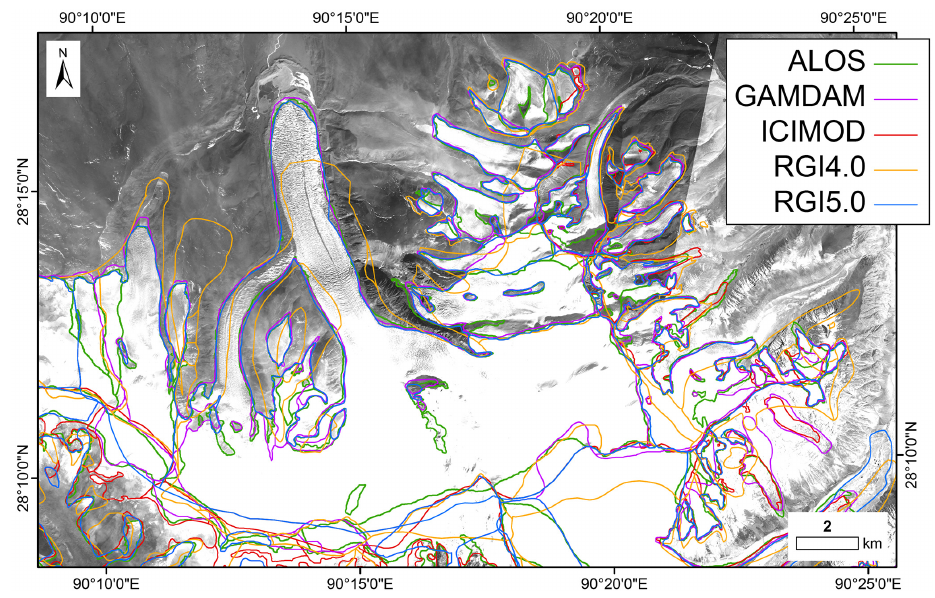
Figure 18. Glacier outlines containing significant distortion in the RGI4.0. These have been improved for the RGI5.0 and are now consistent with other